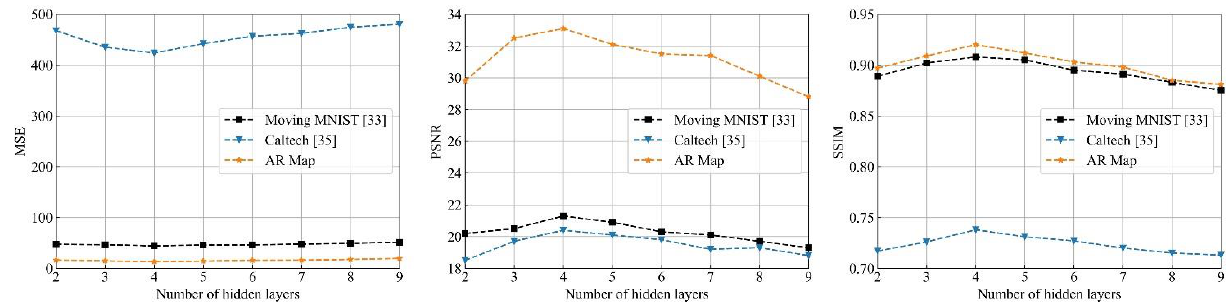
Figure 10. Prediction performance under different number of hidden layers.